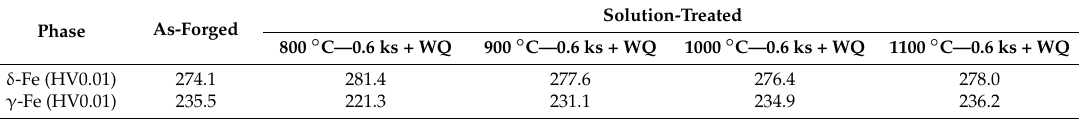
Table 2. Average microhardness values of δ -Fe and γ -Fe phases for all investigated microstructural states. Phase As-Forged